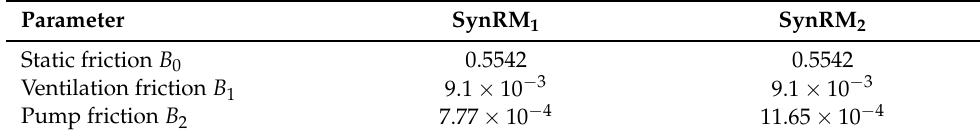
Table 2. Parameters of the virtual load emulator in